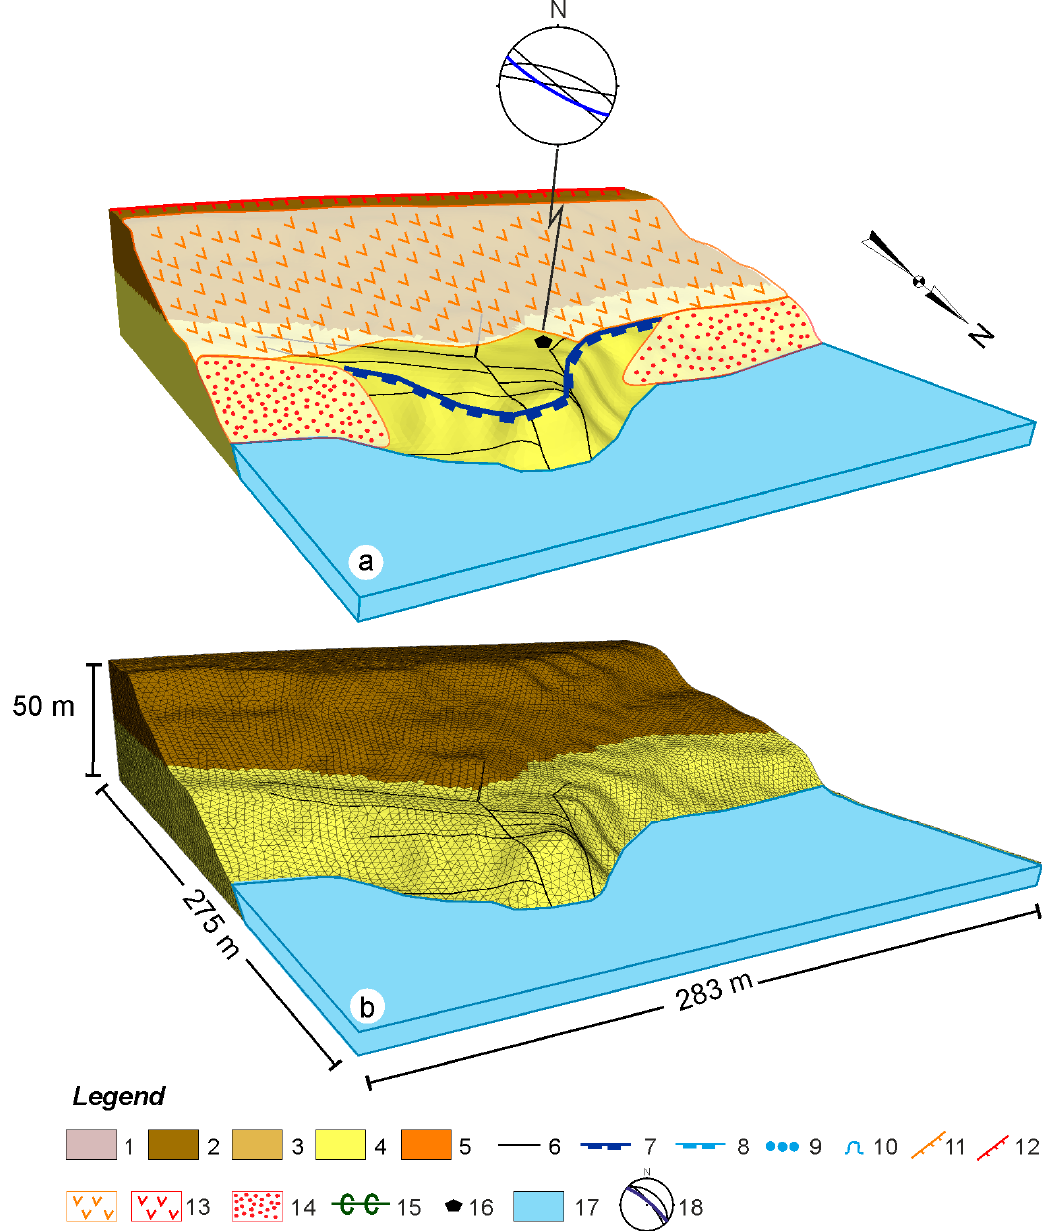
Figure 10. ( a ) The geological and geomorphological model of the Punta Lunga cliff; and ( b ) the simplified model for the numerical modelling (removing superficial deposits < 3m in thickness).